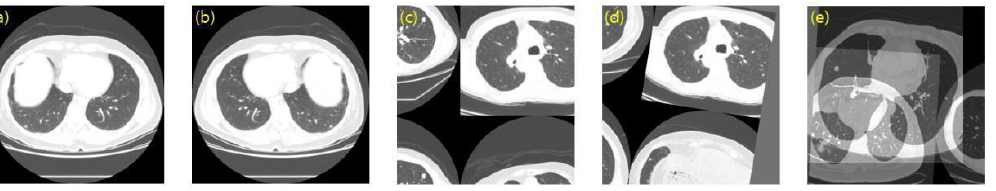
Figure 3. Example of data augmentation applied to lung nodule CT images. ( a ) Original; ( b ) Flip; ( c ) Mosaic; ( d ) Random Affine; ( e ) MixUp.